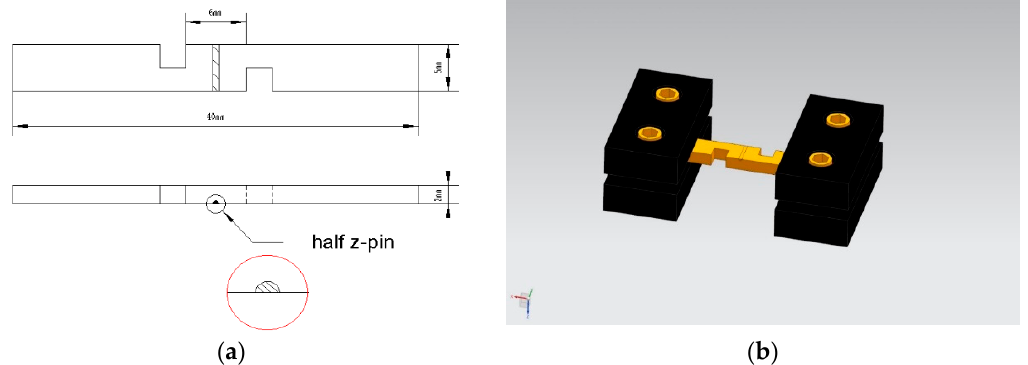
Figure 1. ( a ) The dimensions of the specimen for in situ observation. ( b ) The three-dimensional model of the specimen for in situ observation with the fixture.